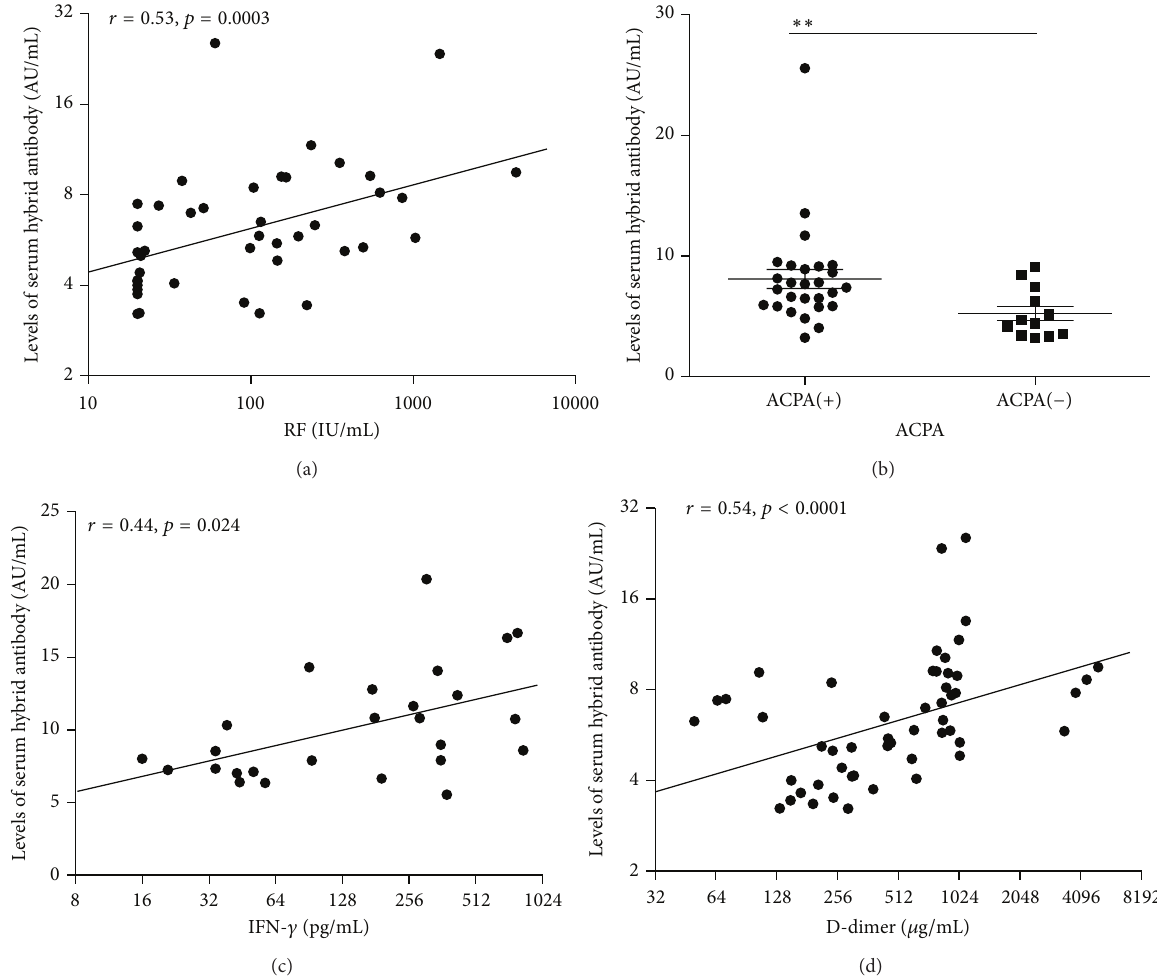
Figure 3: The relationship between serum levels of 𝜅 / 𝜆 hybrid antibody and RA-related clinical parameters. (a) Levels of 𝜅 / 𝜆 hybrid antibody in the serum of RA patients correlated with RF ( 𝑟 = 0.53 , 𝑝 = 0.0003 ). (b) Levels of 𝜅 / 𝜆 hybrid antibody were significantly higher in ACPA(+) than ACPA( − ) group with 𝑝 = 0.0065 ; the differences of 𝜅 / 𝜆 hybrid antibody levels between groups were assessed using the Mann-Whitney 𝑈 test; solid line was labeled at mean with SEM, ∗∗ 𝑝 < 0.01 . (c, d) Levels of 𝜅 / 𝜆 hybrid antibody in the serum of RA patients correlated with IFN- 𝛾 ( 𝑟 = 0.44 , 𝑝 = 0.024 ) and D-dimer ( 𝑟 = 0.54 , 𝑝 < 0.0001 ). Concentrations of 𝜅 / 𝜆 hybrid antibody are presented in arbitrary units (AU/mL). Symbols represent individual subjects. Correlations were determined by Spearman’s rank correlation coefficients with 95% confidence